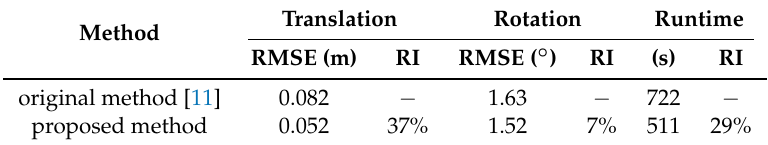
Table 3. Trajectory results of RGB-D SLAM with fr3/long_office_householdsequence.